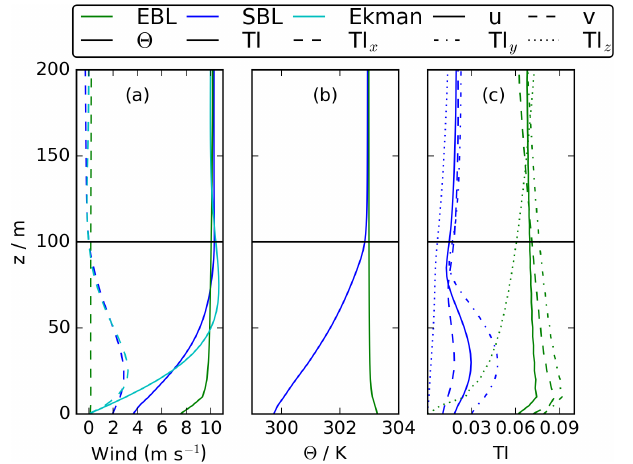
Figure 3. Vertical profiles of the horizontal wind components u and v in (a) , the potential temperature (cid:50) in (b) , and the total TI, streamwise TI x , spanwise TI y , and vertical turbulence intensity TI z in (c) . The profiles represent the horizontal averages of the EBL and the SBL regimes in the precursor diurnal cycle